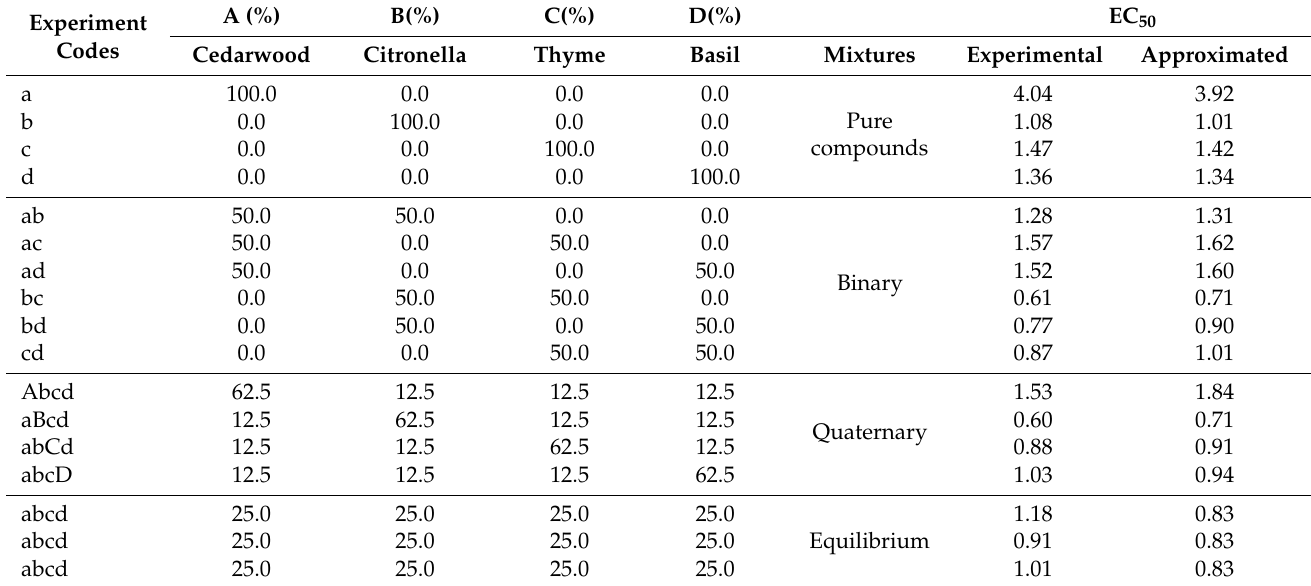
Table 1. The experimental and approximated antioxidant activity of essential oils and their